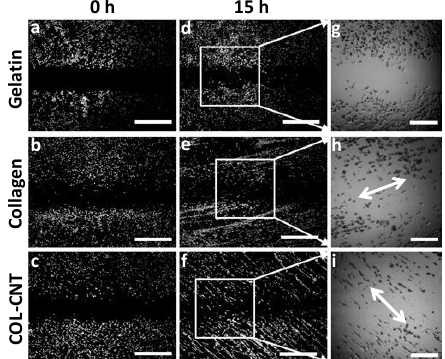
Figure A2. Characterization of cell migration on various matrices by the wound-healing assay. ( a – c ) Optical images of cells at the initial stage (0 h); ( d – f ) optical images of cells after 15 h migration; ( g – i ) enlarged images of ( d – f ) highlighting the cells at the gap region. Arrows indicate the direction of fibril alignment. Bar size of ( a – f ): 800 μm; bar size of ( g – i ): 300 μm. To investigate the matrix effect on cell migration, SKOV3 cells were seeded in two chambers separated by a defined gap of 500 μm. Time-lapse images were collected to monitor cell migration (Figure A2). Apparently, cells on collagen and COL-CNT protruded and migrated preferentially along the fibrils, while cells on gelatin migrated in random directions.